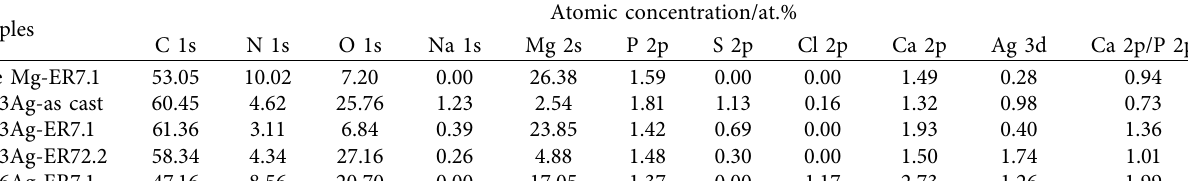
Table 5: Composition of the sample surfaces by XPS after an immersion test for 16 days. Samples